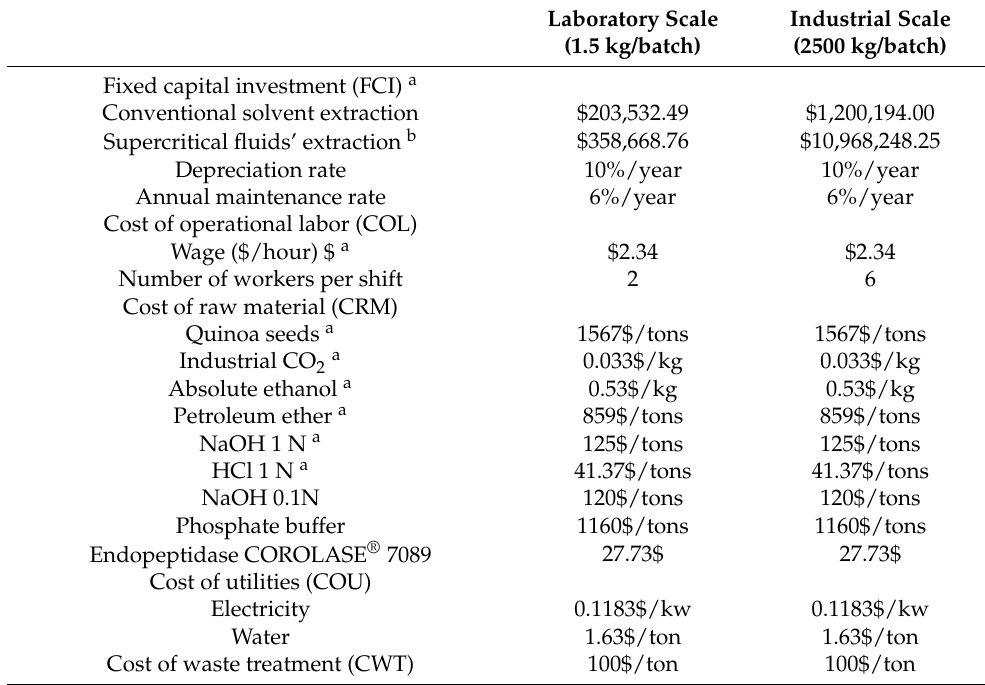
Table 3. Input economic parameters used for COM